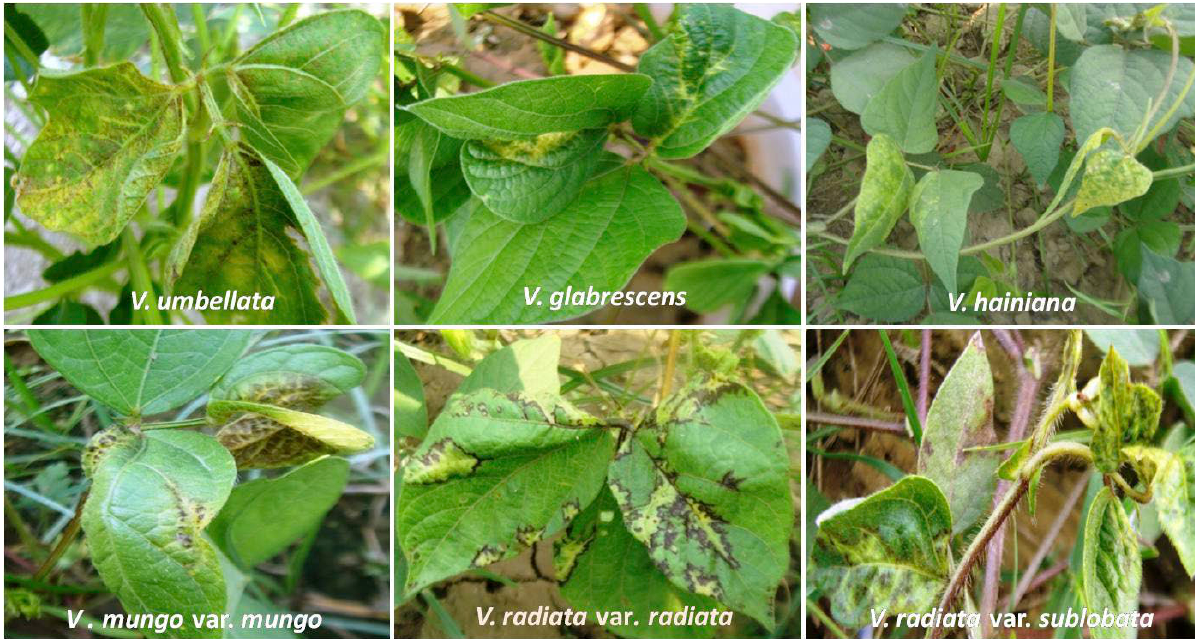
Figure 1. Symptoms of GBNV on naturally infected Vigna umbellata, Vigna hainiana, Vigna glabrescens, Vigna mungo var. mungo, Vigna radiata var. radiata and Vigna radiata var. sublobata